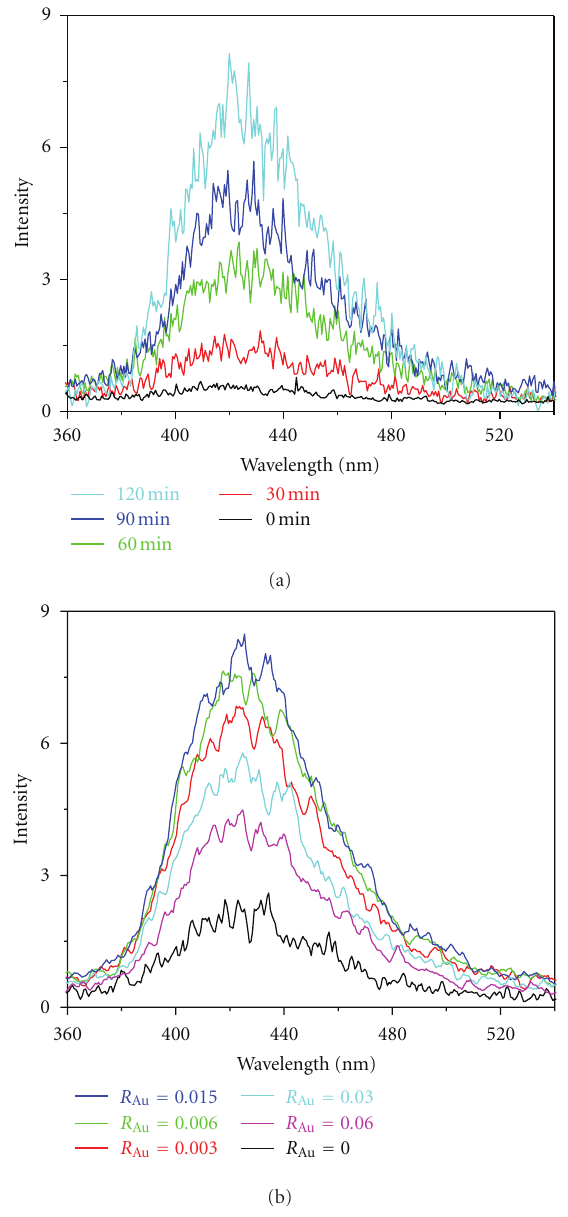
Figure 6: (a) Fluorescence spectral changes with irradiation time on R Au -0.015 sample and (b) the dependence of the fluorescence intensity on R Au at a fixed 120 min under visible-light irradiation.